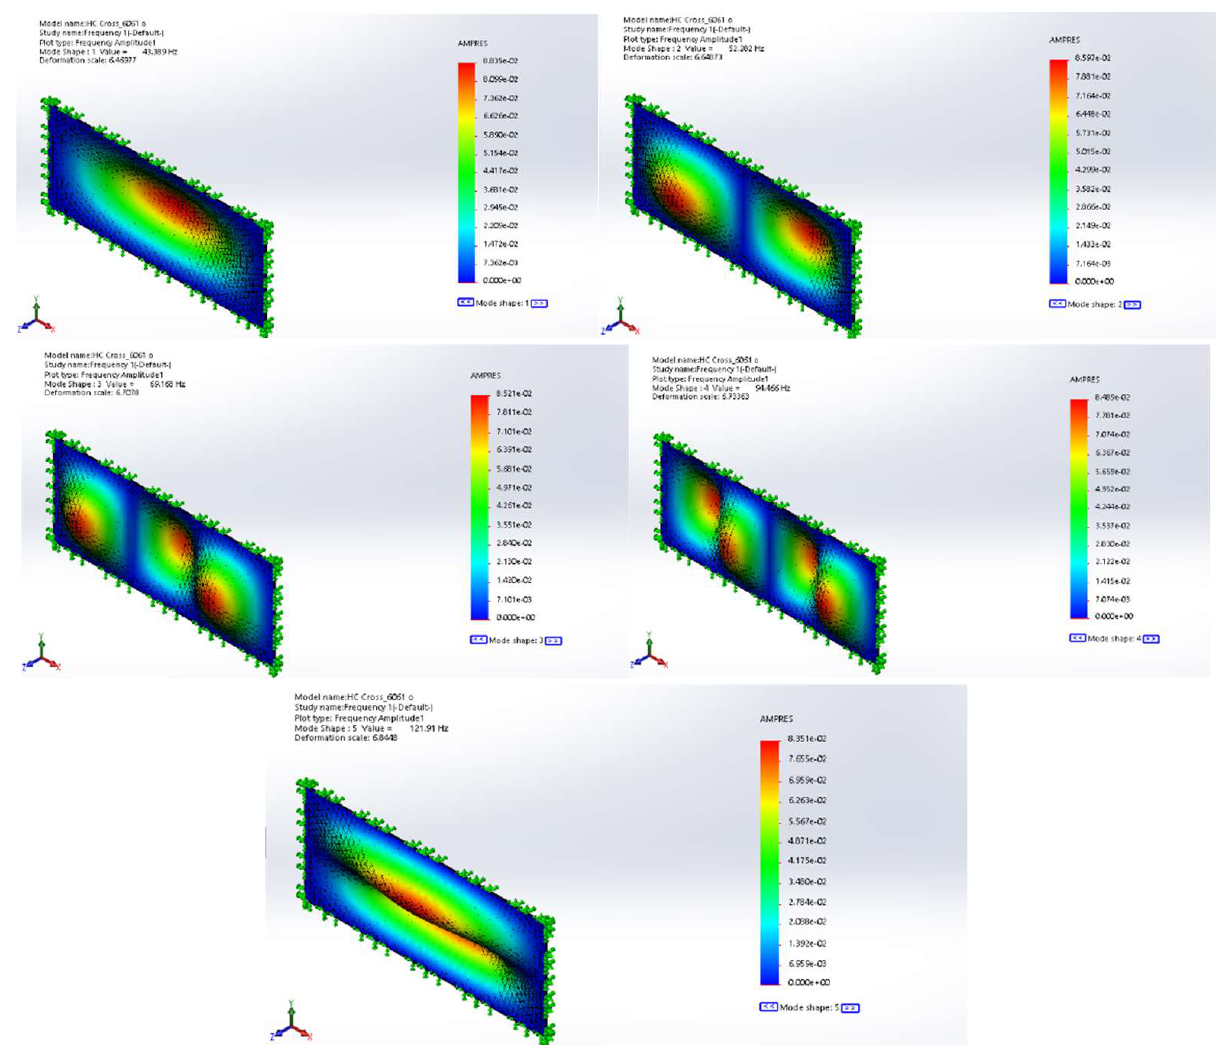
Figure 27: Mode shapes 1–5 of the cross